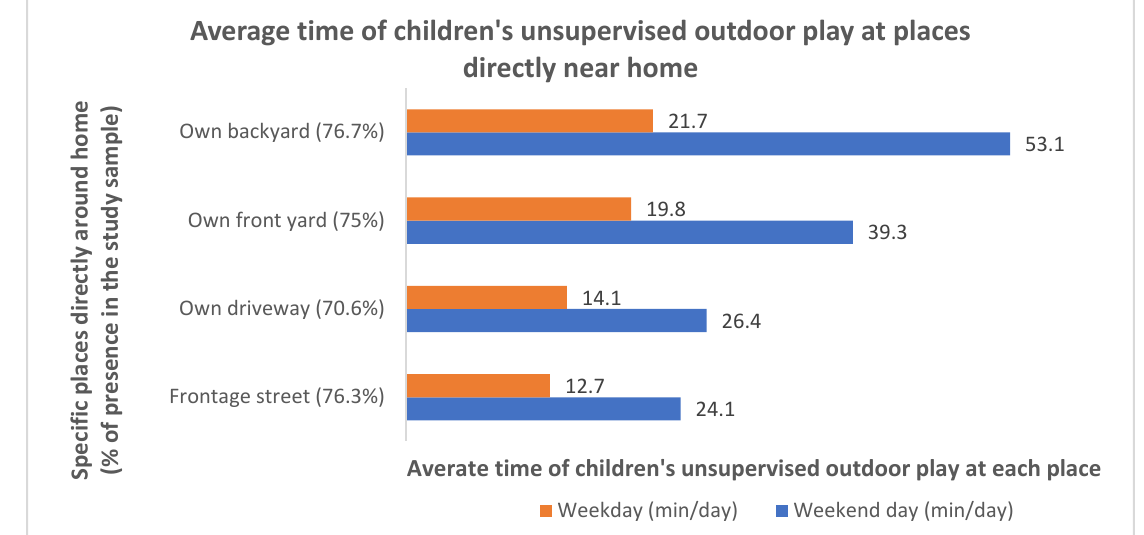
Figure 6. Percentages of participants with specific places directly near home and among them the average time their child spent at each place for unsupervised outdoor play.